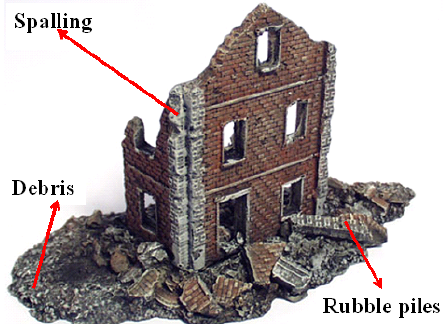
Figure 1. An example of debris, rubble piles, and spalling.